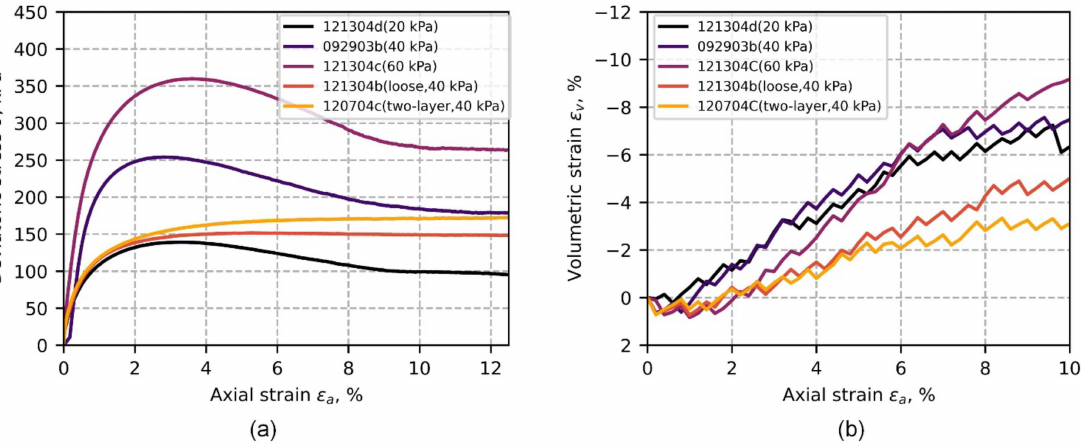
Figure 1. Global material responses: ( a ) triaxial stress-strain curves; ( b ) axial strain-volumetric strain